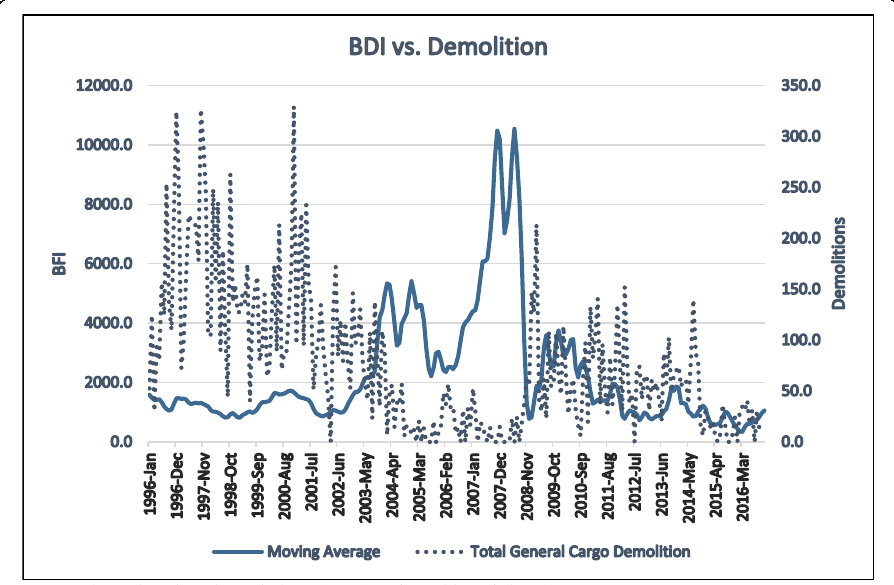
Fig. 5 The BDI moving average versus Total DWT of General Cargo Ships Demolished. Source: the authors based on Clarkson (2017) and World Bank